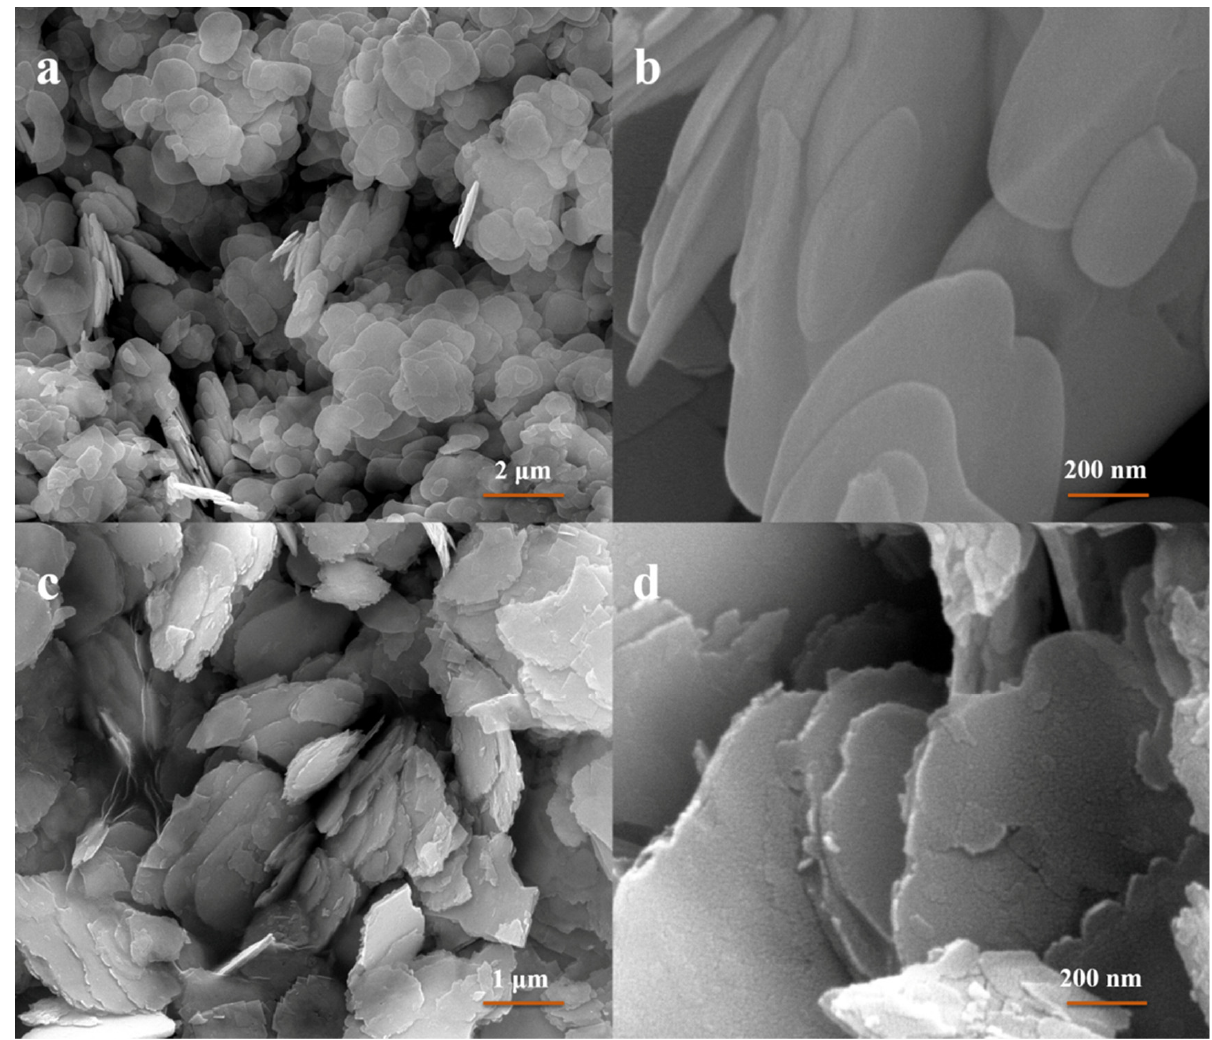
Figure 3. FE-SEM images of pure BiOCl nanoplates ( a , b ) and BC-3 nanocomposite( c , d ).